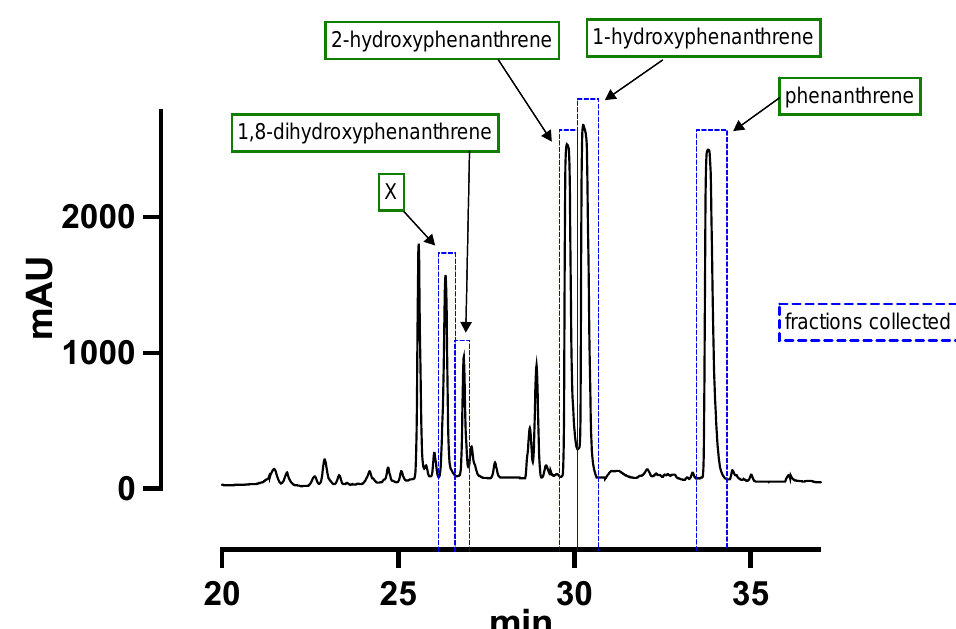
Scheme 1. Products identified from the CYP5035S7-catalysed biotransformations of 2 , 3 , 4 , 5, and 6 employing a P. pastoris whole-cell biocatalyst.